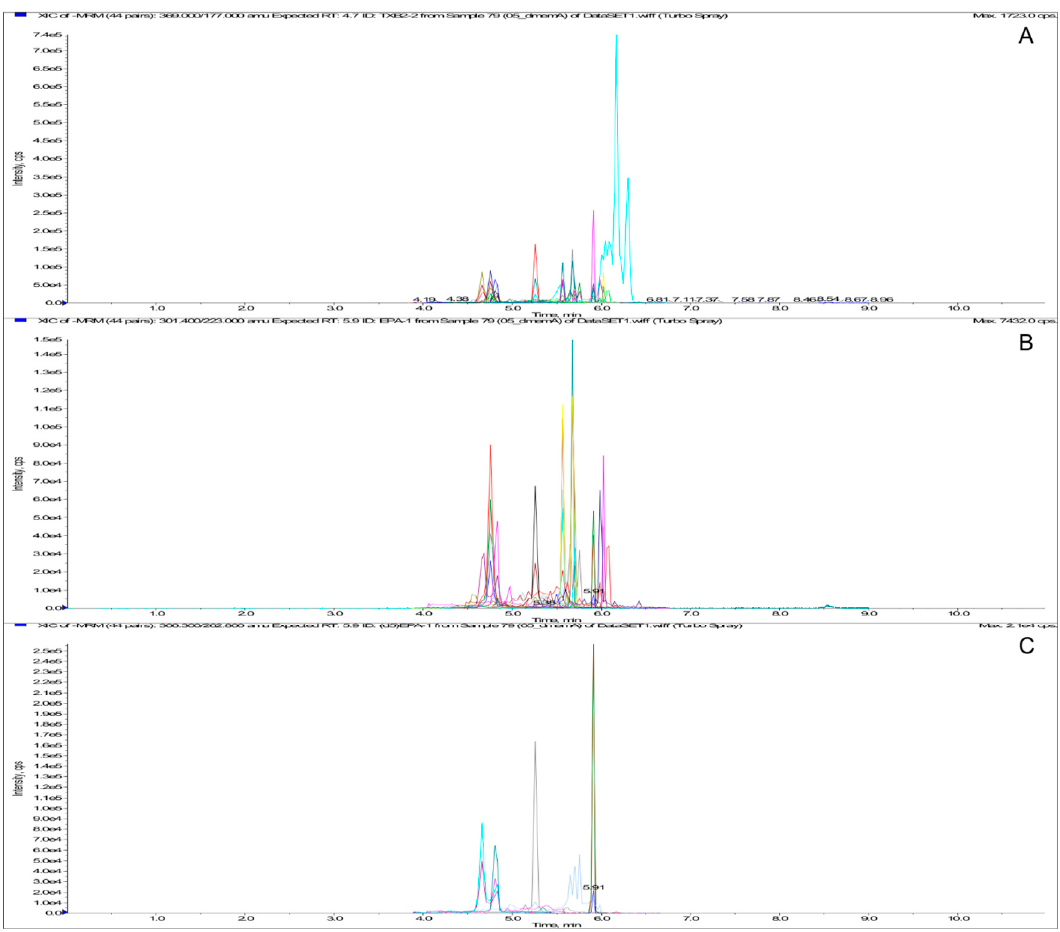
Figure 2. MRM chromatogram of PUFAs / eicosanoids extract. From the top: Total ion Current ( A ), standard extraction (0.5 and 5 ng / mL for AA, EPA, and DHA) ( B ), and ISs extraction ( C ).